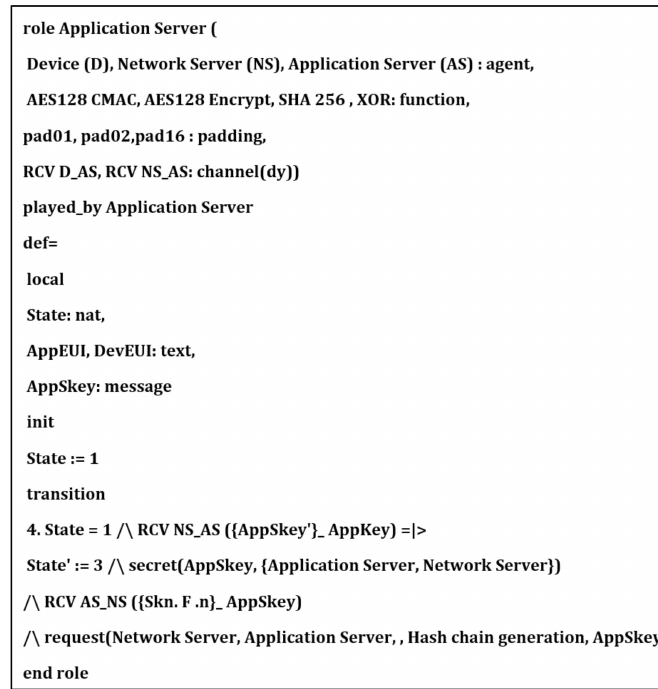
Figure 11. Application server role using HLPSL and